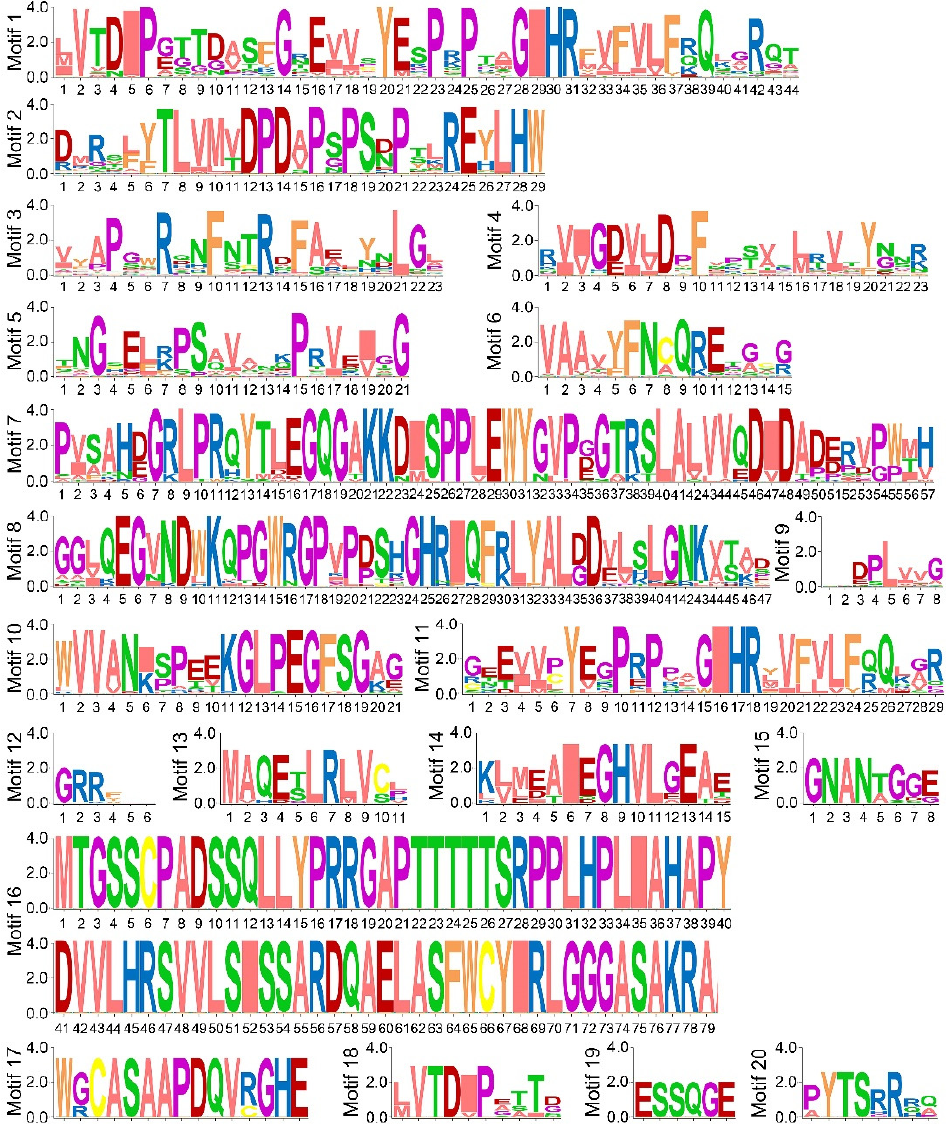
Figure 5. Motifs found in PEBP domain-containing proteins of crops. The height of different amino acids represents frequency of occurrence. The scale bar at the bottom indicates the length of the motif protein sequence.